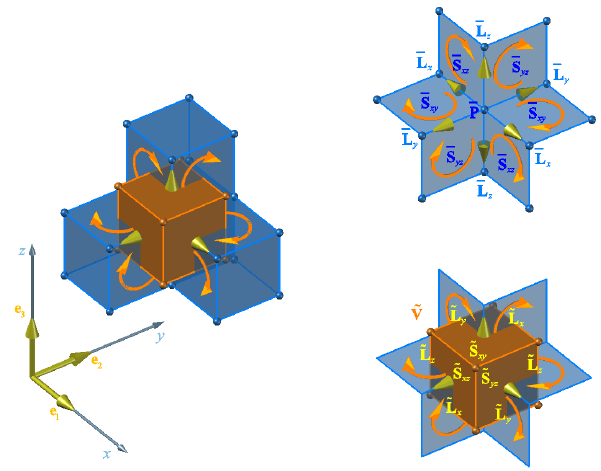
Figure 6: Relation of duality in three-dimensional space, between inner orientations of the primal cells and outer orientations of the dual